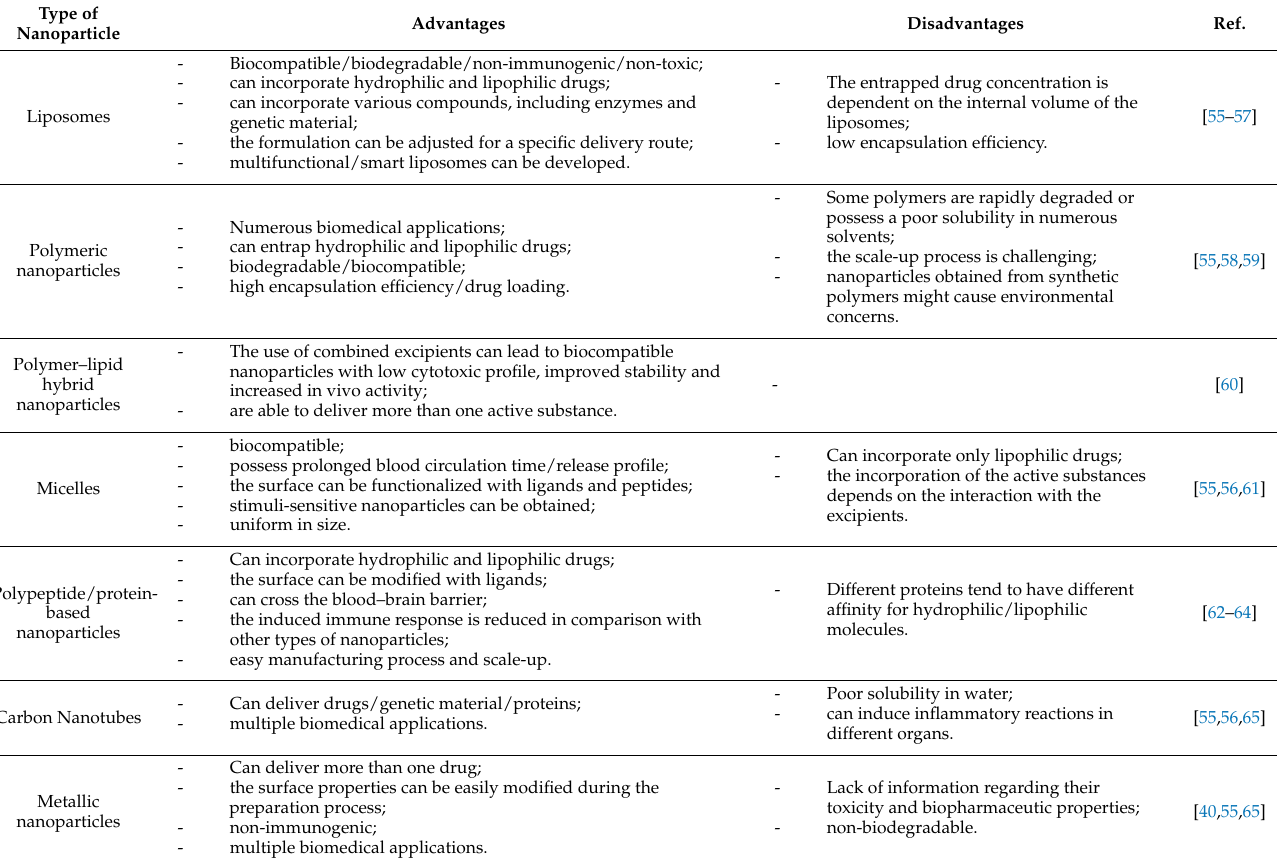
Table 1. The advantages and disadvantages of different types of nanoparticles used for the drug delivery of Sali. Type of